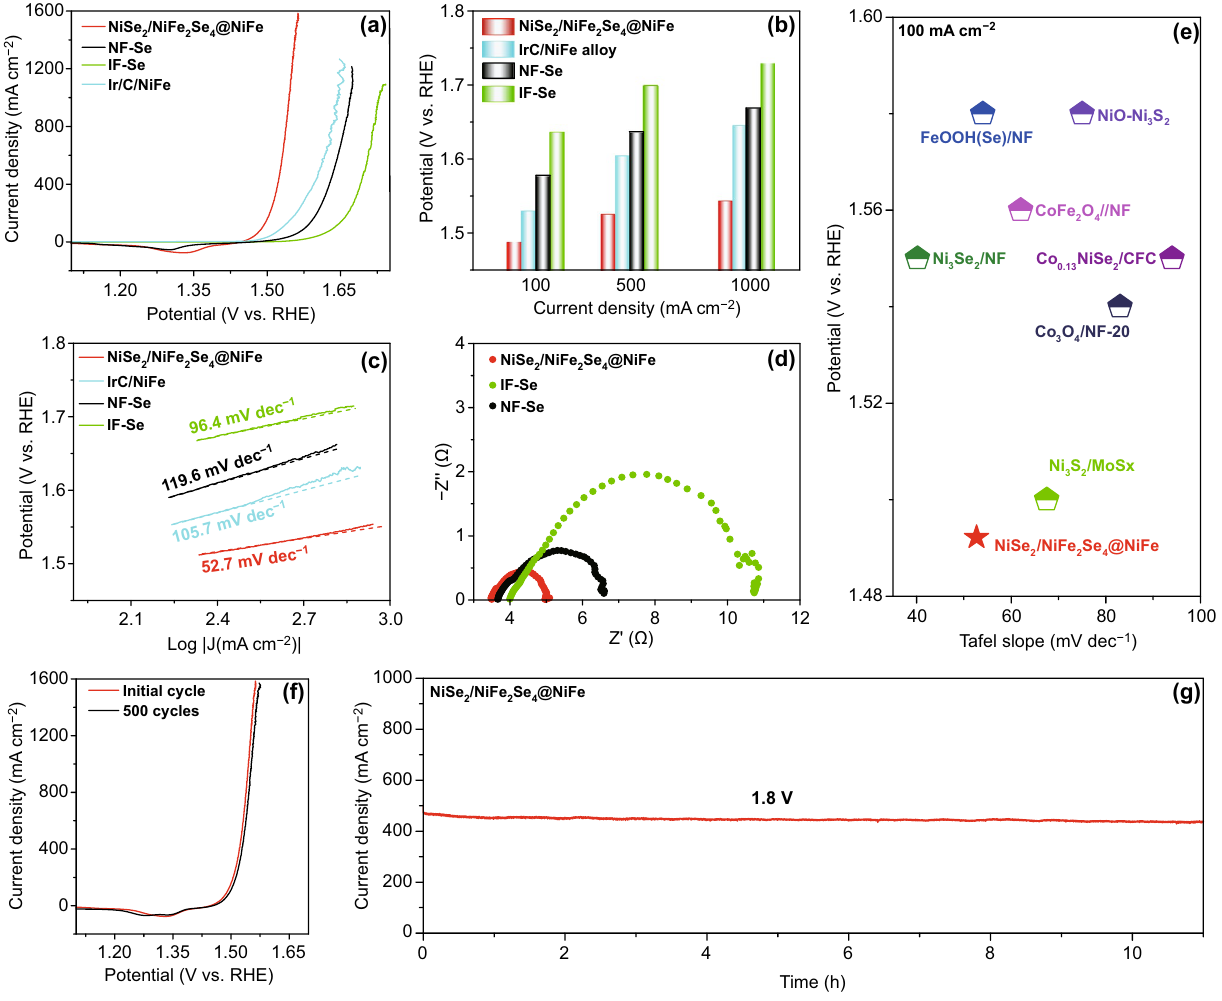
Fig. 2 a Polarization curves of NiSe 2 /NiFe 2 Se 4 @NiFe, NF-Se, IF-Se, and Ir/C/NiFe with iR compensation. b Comparison of potentials required at 100, 500, and 1000 mA cm −2 for NiSe 2 /NiFe 2 Se 4 @NiFe, NF-Se, IF-Se, and Ir/C/NiFe. c Tafel plots of NiSe 2 /NiFe 2 Se 4 @NiFe, NF-Se, IF-Se, and Ir/C/NiFe. d Nyquist plots of NiSe 2 /NiFe 2 Se 4 @NiFe, NF-Se, and IF-Se. e Comparison of Tafel slopes and potentials required for 100 mA cm −2 . f Polarization curves of NiSe 2 /NiFe 2 Se 4 @NiFe before and after 500 cycles with iR compensation. g Chronoamperometry curve with the NiSe 2 /NiFe 2 Se 4 @NiFe as electrode at 1.8 V without iR compensation. Electrolyte: 1.0 M